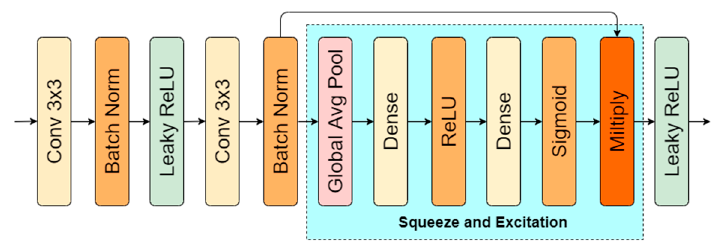
Figure 4. Squeeze and excitation block